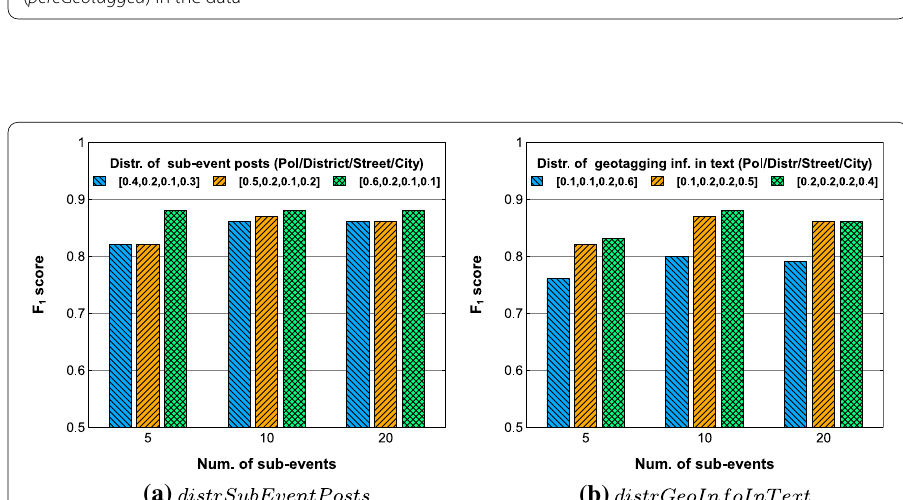
Fig. 7 F1-score for different percentage distributions among the four levels ( PoI , street , district , city ) of geotagged posts ( distrSubEventPosts ) and textual information that allows to estimate coordinates of a